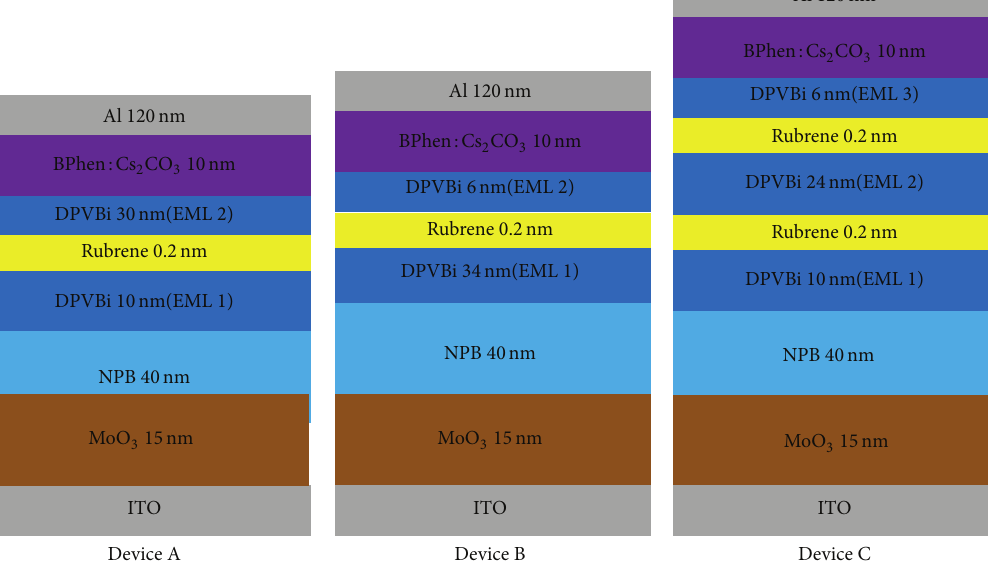
Figure 5: The structure of